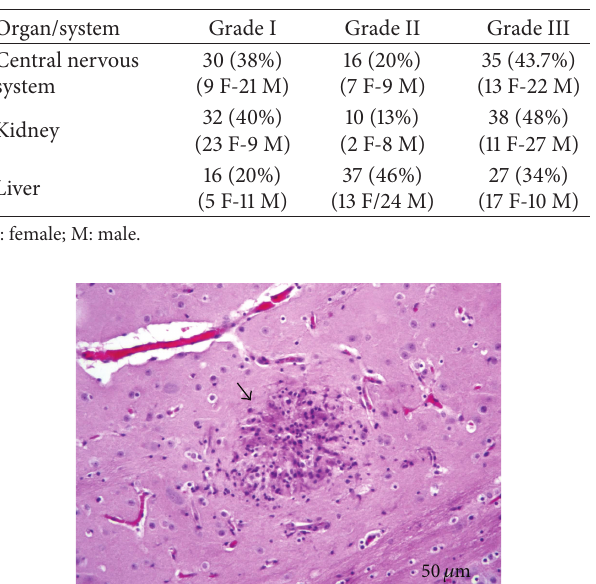
Table 1: Number of rabbits exhibiting the different grading in several organs/system.